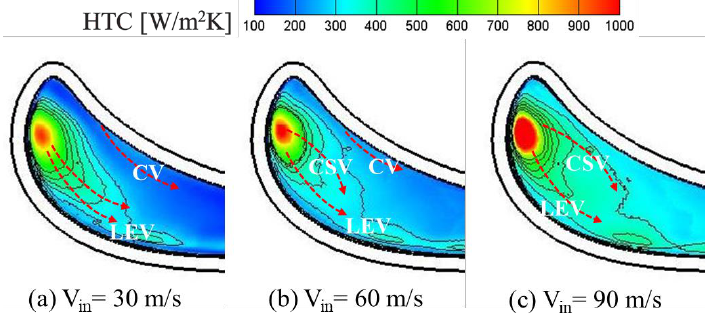
Figure 11. Detailed HTC of squealer tip at each velocity condition (x/Cx < 0.4, squealer tip).